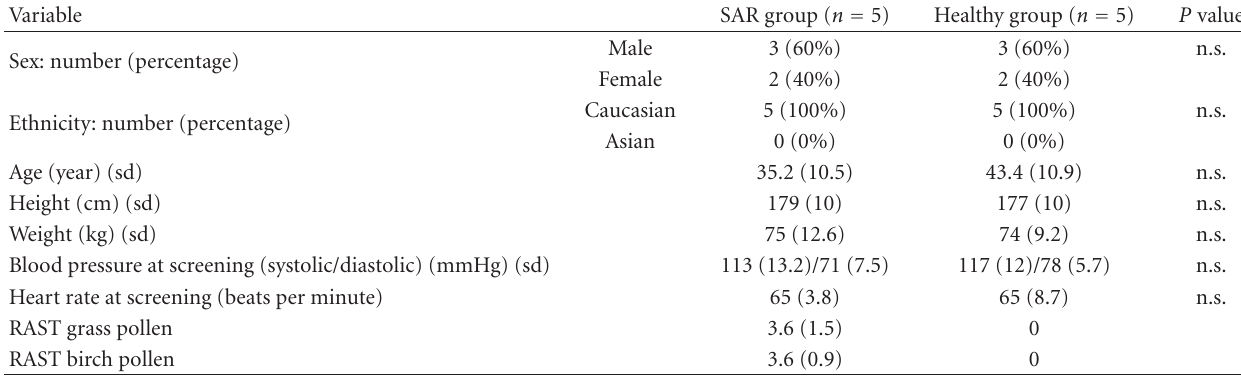
Table 1: Baseline characteristics seasonal allergic rhinitis (SAR) group and healthy group.